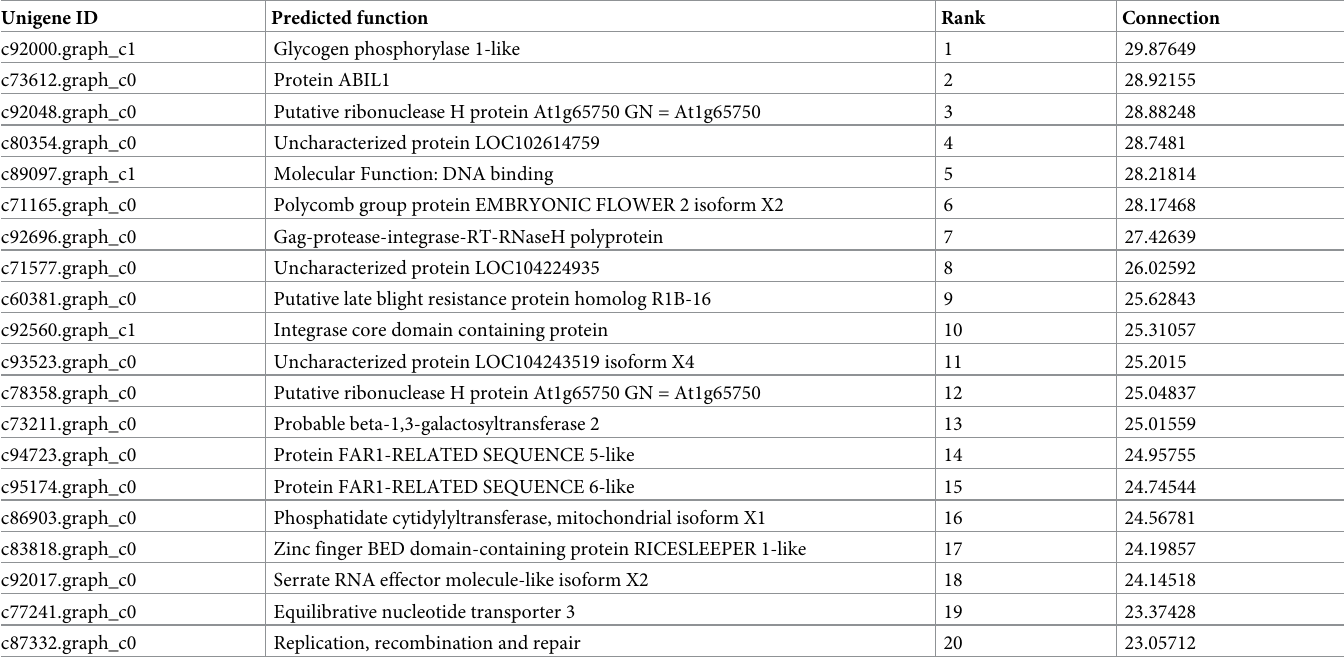
Table 5. Top 20 genes enriched in cyan module.